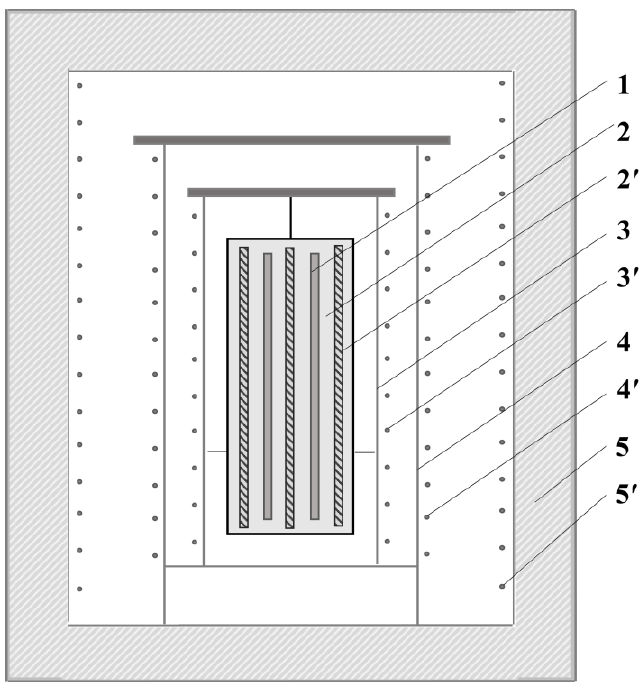
Figure 1. A simplified diagram of the precision adiabatic calorimeter. Test sample (1) is placed in the silver cell (2) with cell heater ( 2′ ); an inner adiabatic shell (3) with a heater ( 3′ ) and an outer adiabatic shell (4) with a heater ( 4′ ) provide adiabatic conditions; a protective cap (5) with a heater ( 5′ ) isolates the system from the environment.